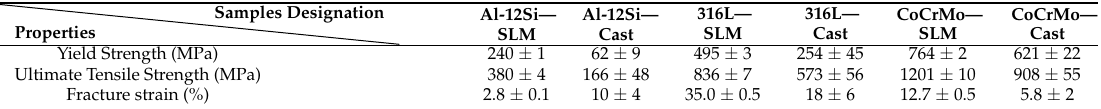
Figure 3. Room temperature tensile curves for ( a ) CoCrMo and commercially pure Ti (CP-Ti) and ( b ) 316L and Cu-10Sn bronze materials. 4. Conclusions Five different metal/alloy systems (Al-12Si, Cu-10Sn and 316L—face centered cubic phase and CoCrMo and CP-Ti—hexagonal closed packed phase) were fabricated by SLM using commercially available parameters. The Al-12Si fcc samples show uniform and consistent mechanical, tribological and corrosion properties within the experimental errors. It is noteworthy that the room temperature tensile curves overlap one another up to the yield point and show similar behavior, beyond yielding or marginal differences in the ultimate tensile strength (difference ~10 MPa) and/or ductility (~0.2%), thus demonstrating the reliability of the samples fabricated by SLM. Similar tensile results were observed in the case of the other four metal/alloy systems (Cu-10Sn, 316L, CoCrMo and CP-Ti), where the room temperature curves show consistency in their mechanical properties. These results suggest that the selective laser melting process can be used to produce parts with consistent and reproducible properties, provided the powder quality and the parameters for fabrication remain the same.